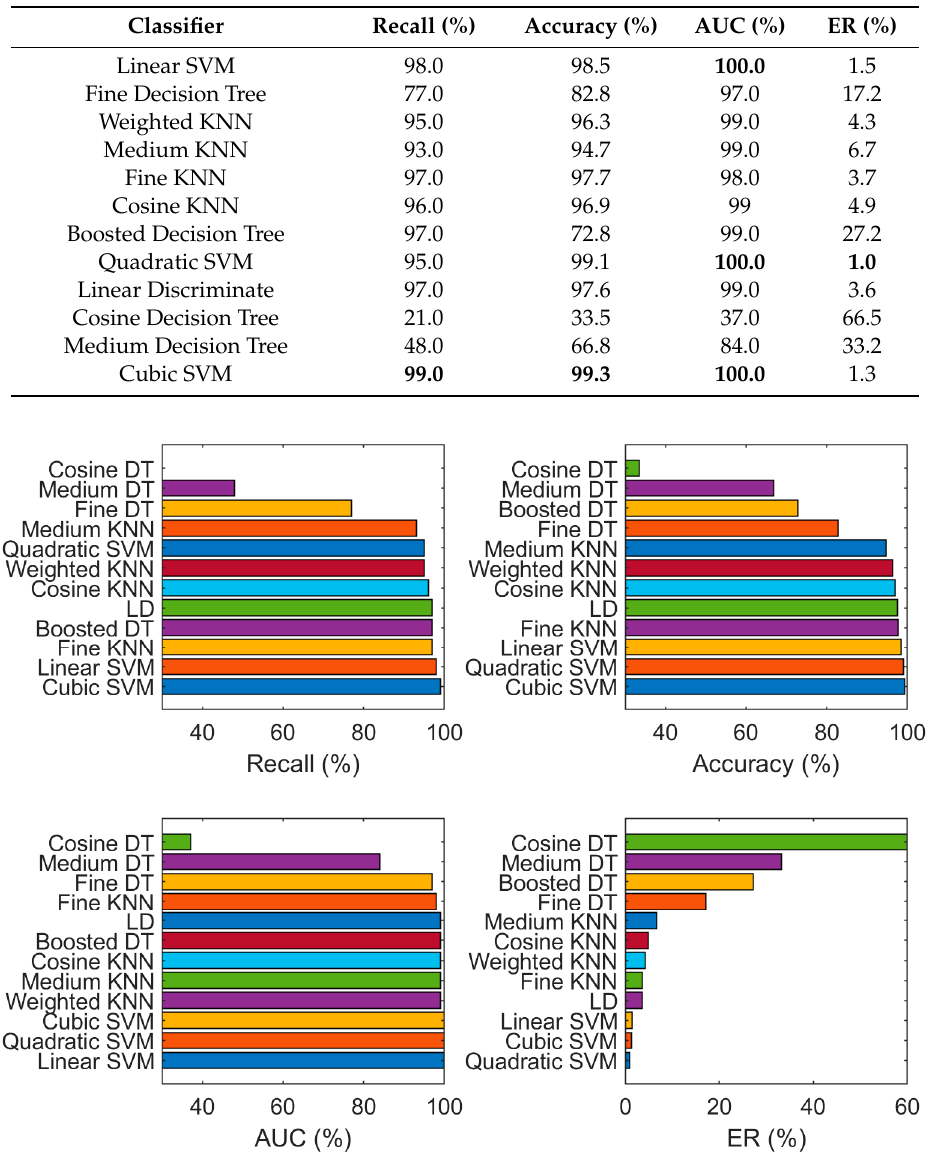
Figure 10. Classification results (recall, accuracy, AUC and ER) using a fusion of SFTA and pre-trained network features on the balanced (augmented) dataset.